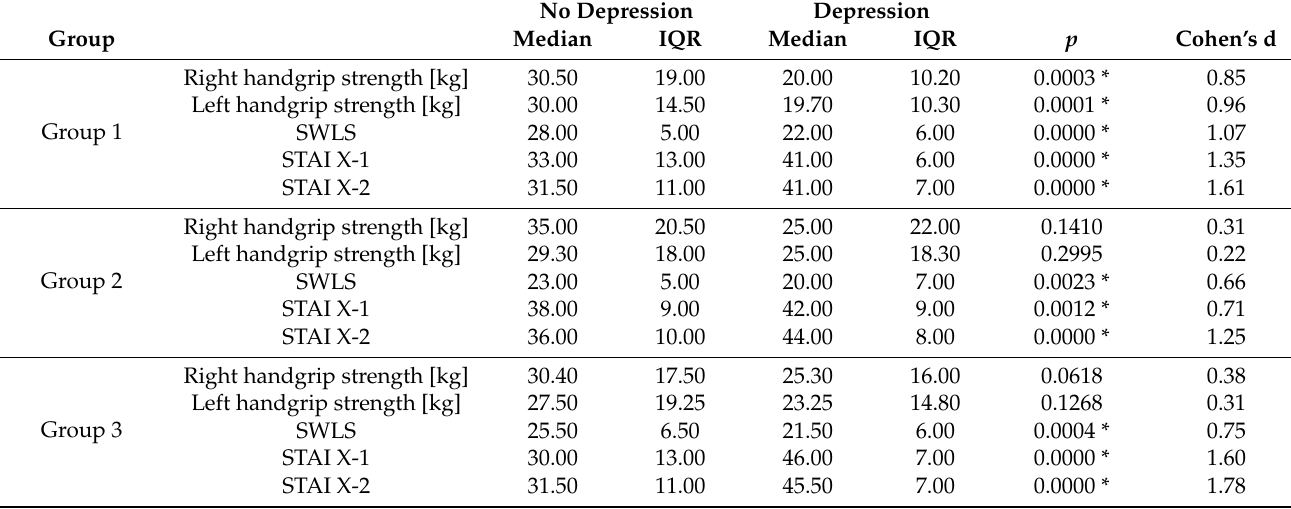
Table 7. Within-group differences between subjects with and without depressive symptoms (the Mann–Whitney